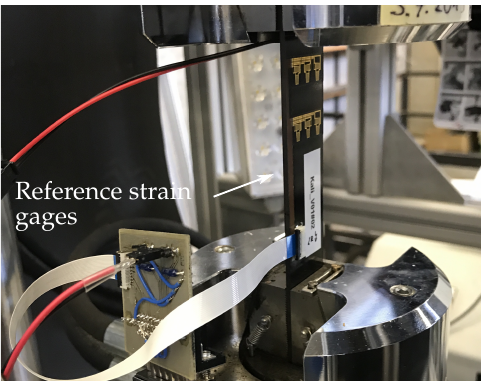
Figure 2. Calibration setup inside tensile rig with clamped open (lap-free)